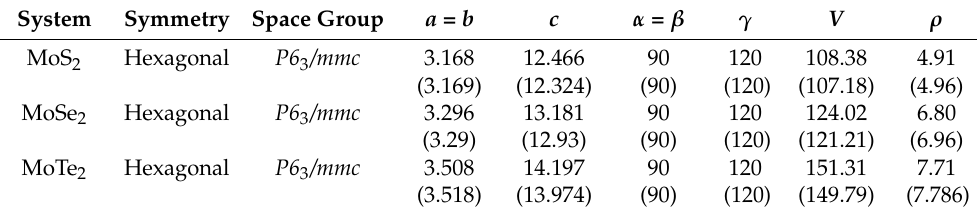
Table 1. Comparison of SCAN- rVV10 computed lattice properties with those reported experimentally for bulk 2H-MoCh 2 (Ch = S, Se, Te). Experimental values are given in parentheses in each second line